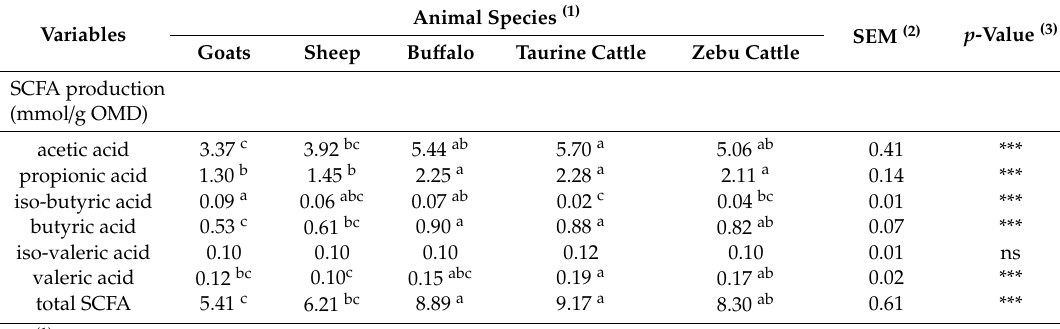
Figure 2. Effects of animal species on gas production profiles during in vitro rumen fermentation (pooled over condensed tannin treatments in four forages). Table 5. Effect of animal species on short-chain fatty acids (SCFA) production evaluated during in vitro rumen fermentation.